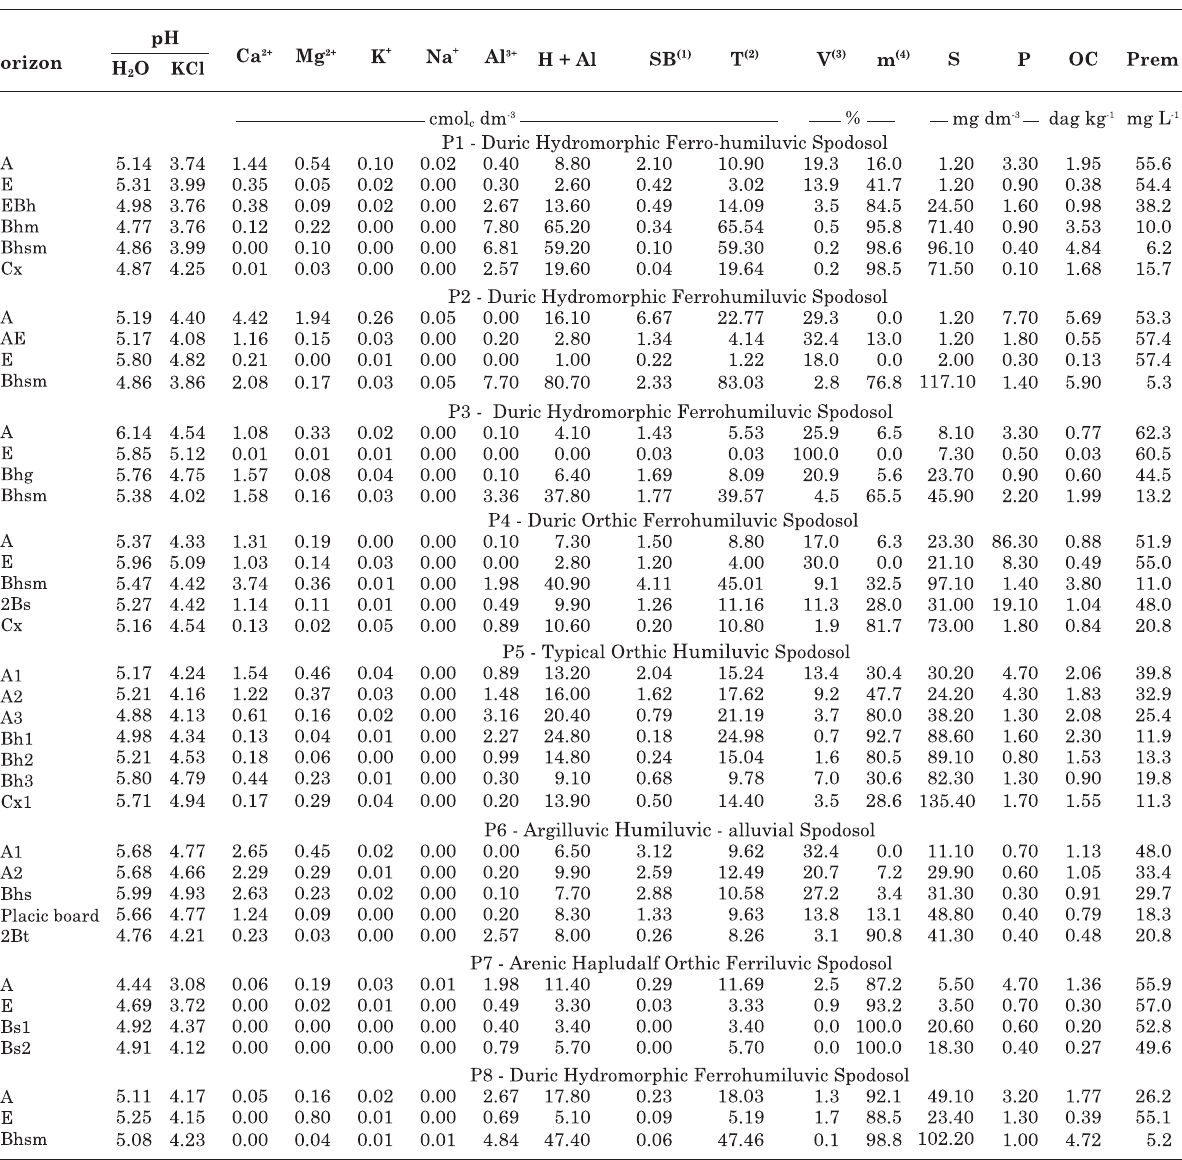
Table 3. Chemical properties of soil